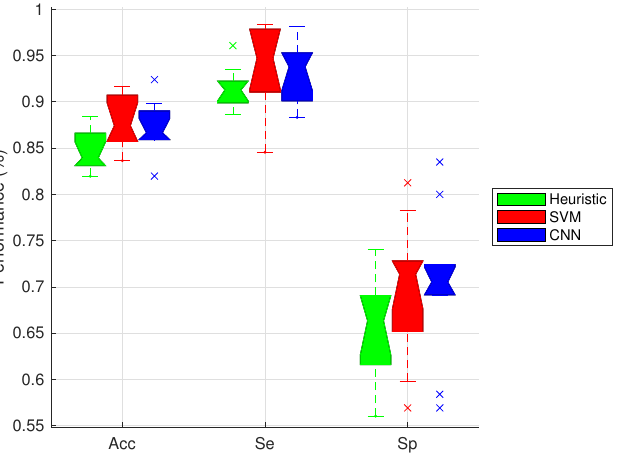
Figure 7. Comparison of the performance metrics of the three approaches: heuristic (green), SVM (red) and CNN (blue). The only significant difference ( p < 0.05) was obtained between the Acc of the heuristic and the both machine learning